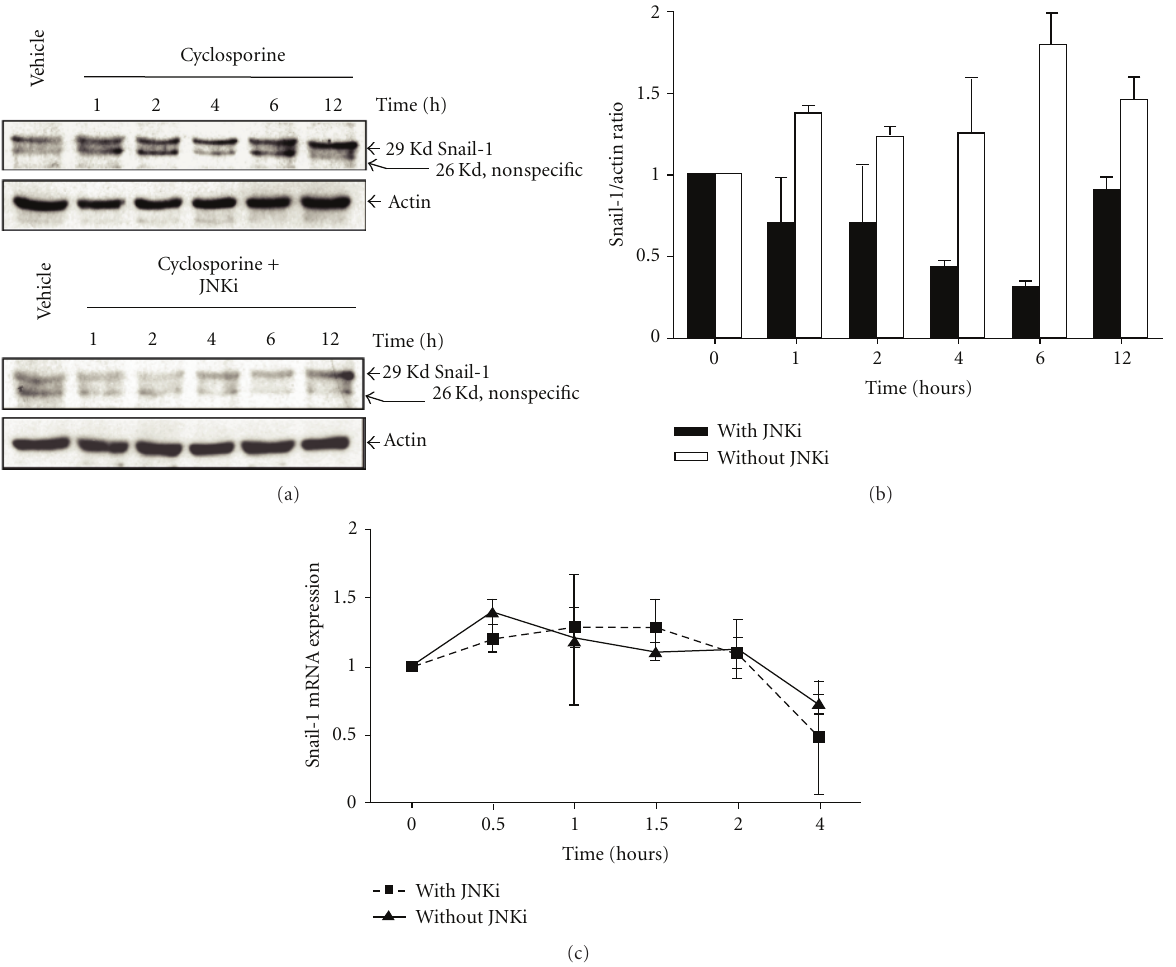
Figure 3: Cyclosporine induces Snail-1 expression in a JNK-dependent manner. (a) Representative western blot of Snail-1 expression in tubular cells during exposure for various incubation times with 6 μ M CsA or 6 μ M CsA + (L)-JNKI1. (b) Densitometric analysis of Snail-1 expression in three independent experiments. ∗ P < 0 . 05 versus control. (c) Real-time PCR analysis of Snail-1 mRNA expression in tubular cells that were exposed for various incubation times with 6 μ M CsA with or without 2 μ M